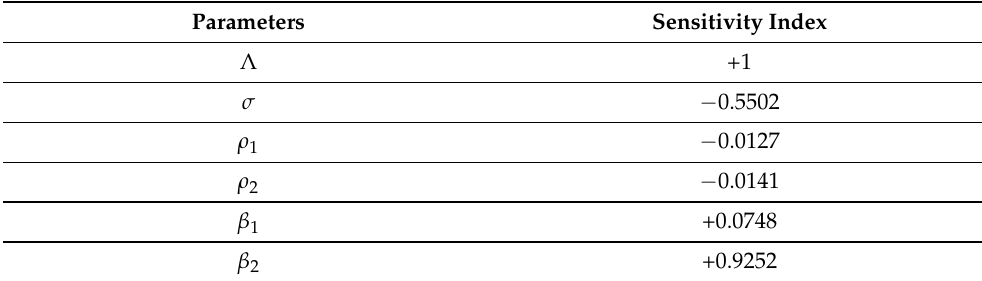
Table 2. Sensitivity indices of different parameters of system (1) corresponding to Table